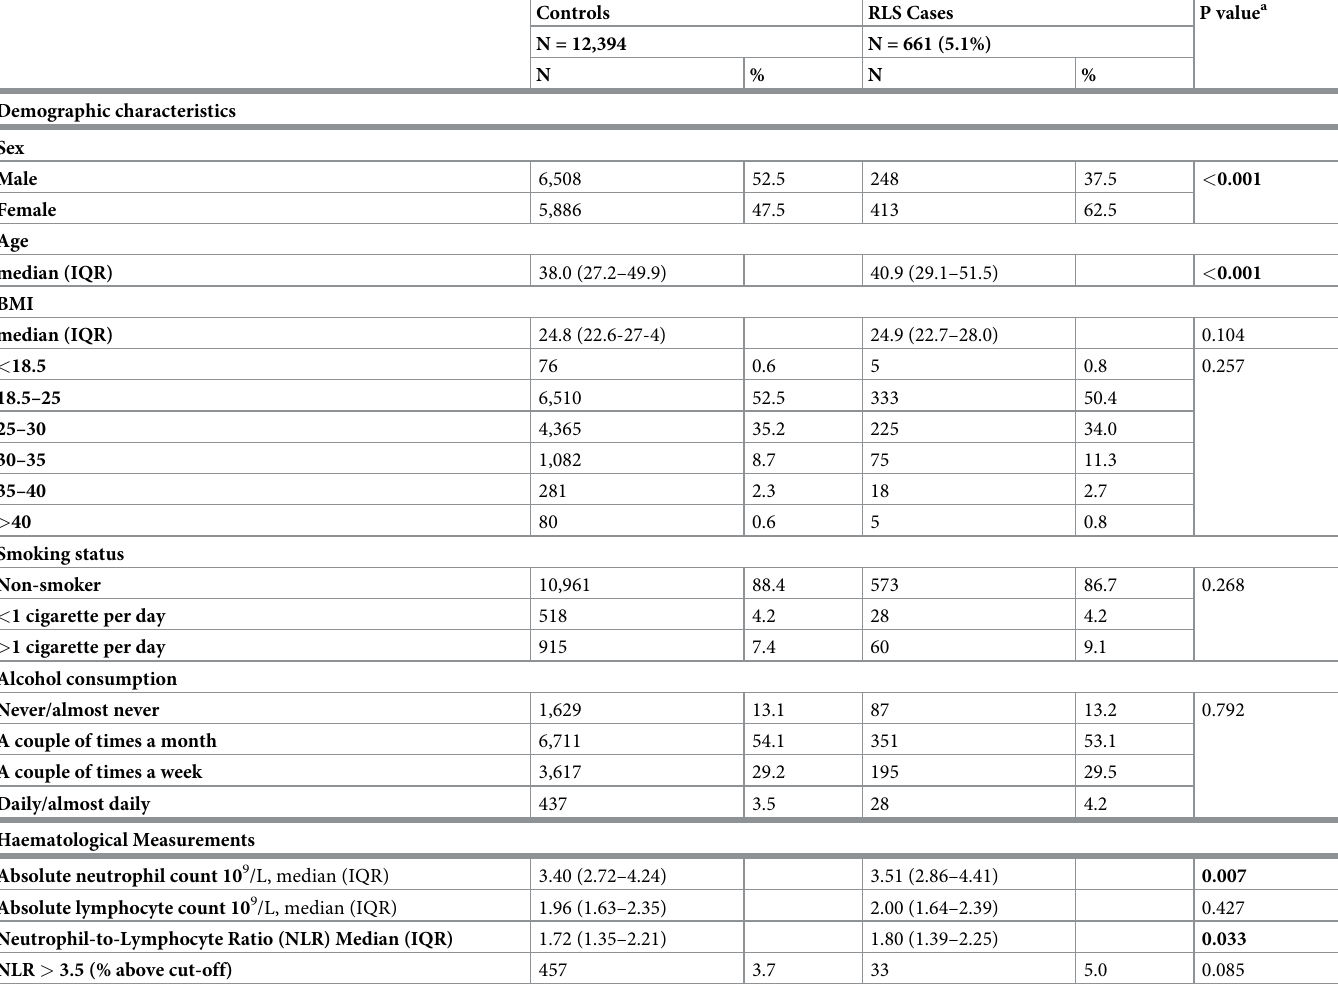
a For comparison of the two groups, chi-square test was used for categorical variables and Kruskal-Wallis rank test was used for continuous